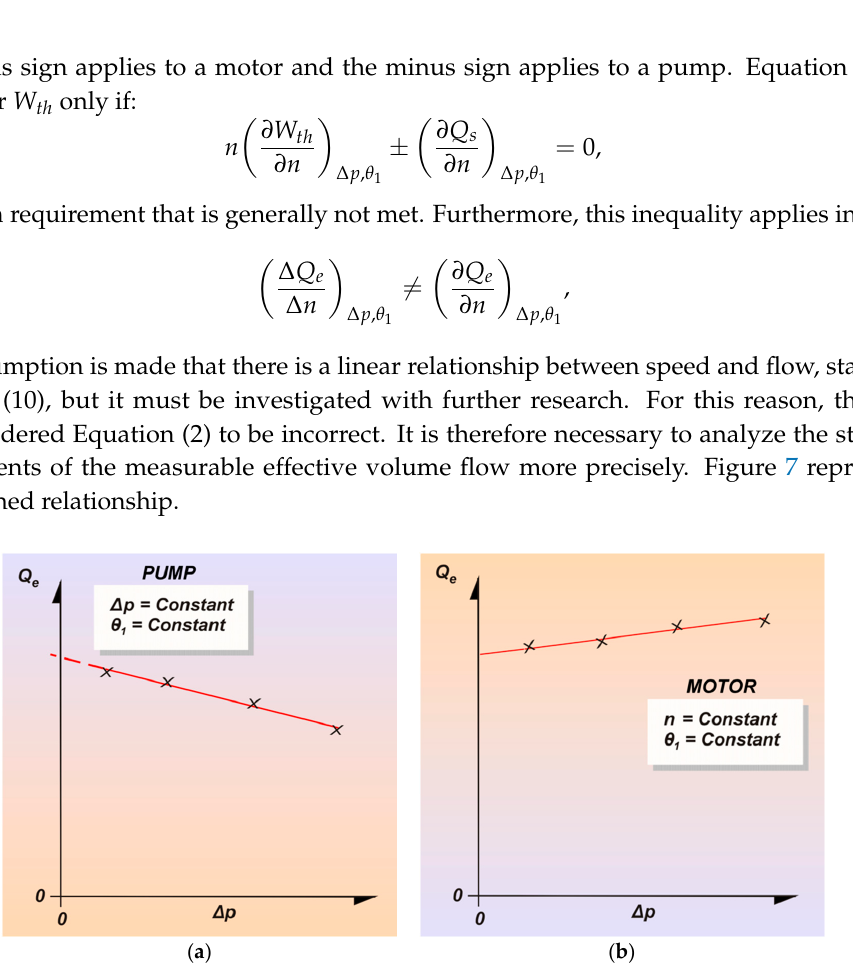
Figure 7. The ∂ Q e / ∂ n vs. the pressure difference, Δ p , for ( a ) a positive displacement pump and ( b ) a positive displacement motor. a positive displacement